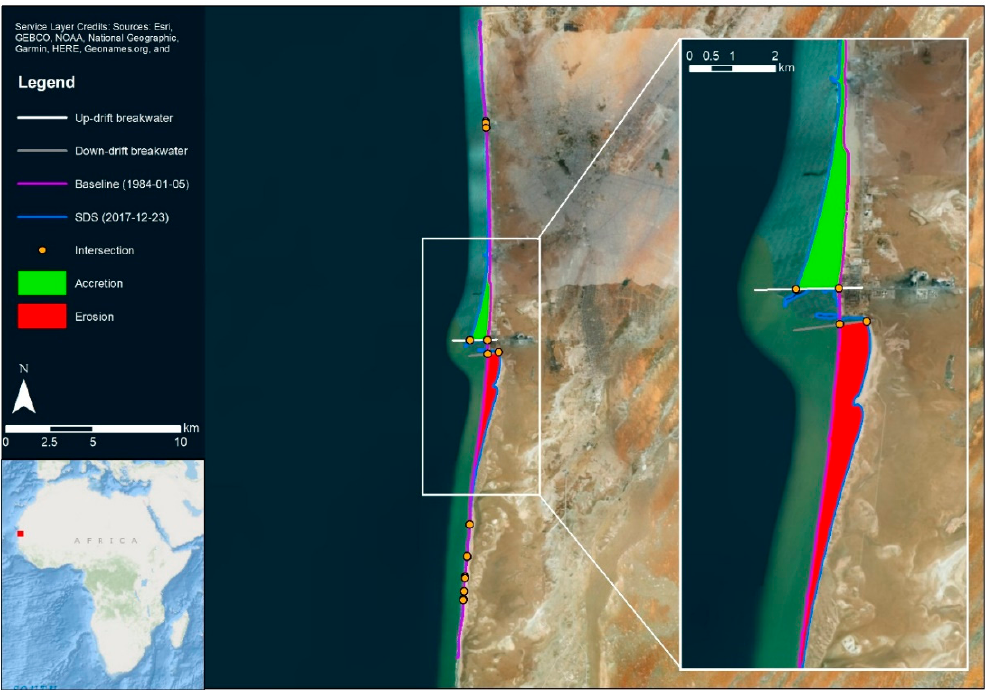
Figure 4. Example of the beach area change detected for the port of Nouakchott (Mauritania) between January 1984 and December 2017 with a close-up zoom of the areal changes near the port. As in Figure 3, the baseline is indicated in purple, the latest satellite derived shoreline (SDS) in blue, the erosion area in red, the accretion area in green, and the intersections by orange dots.